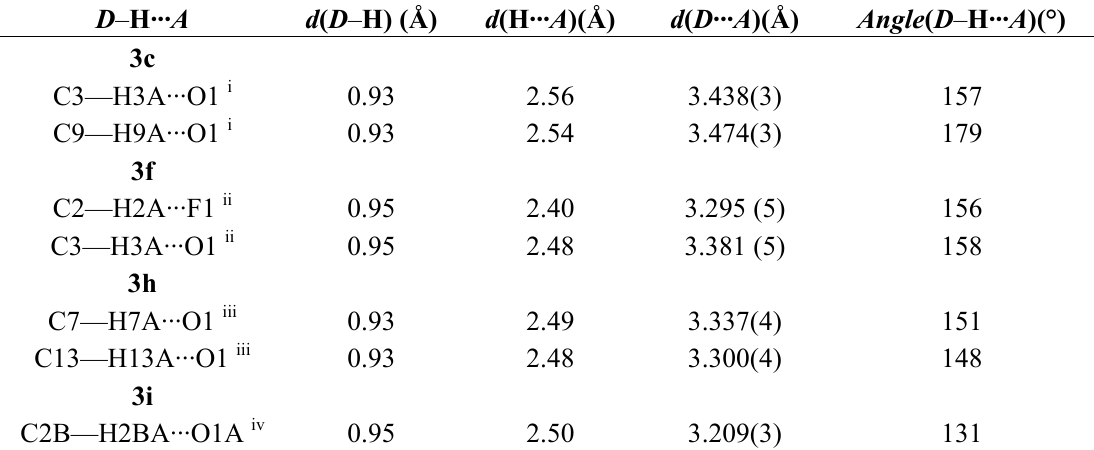
Table 3. Hydrogen bond geometries for the compounds 3c , 3f , 3h and 3i